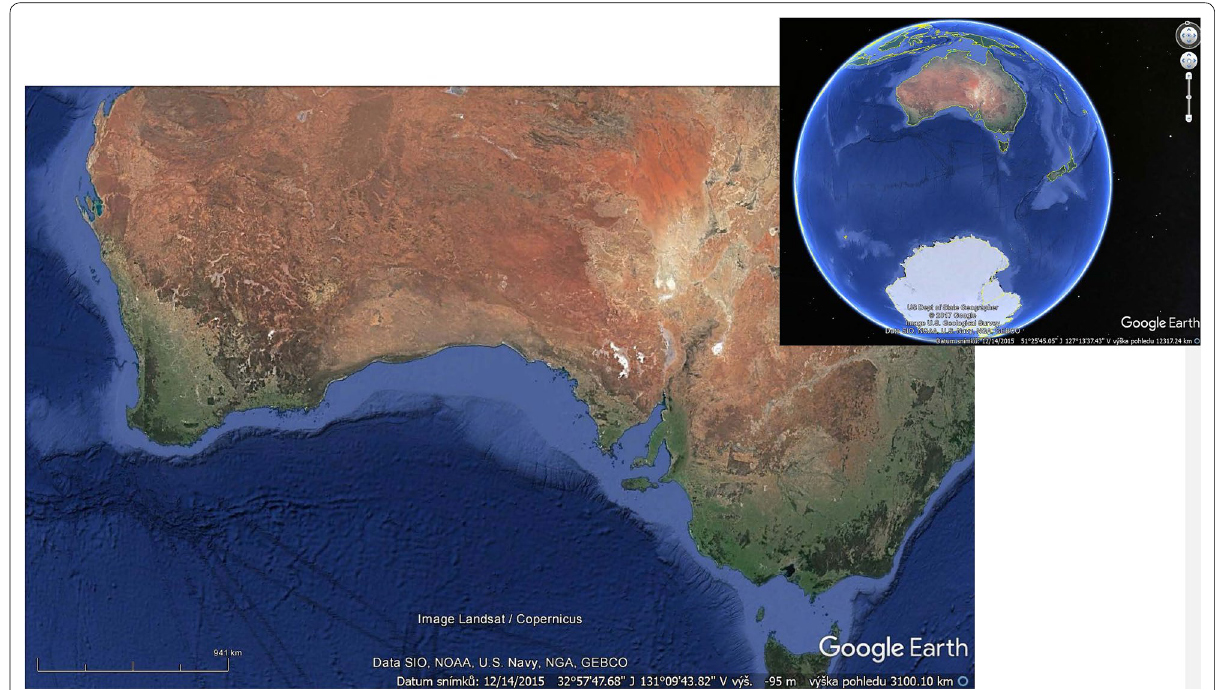
Fig. 13 Southern Australia topography from Google Earth ©. The inset is a zoom-in map to recall the similarity of the coastlines of southern Australia and East Antarctica